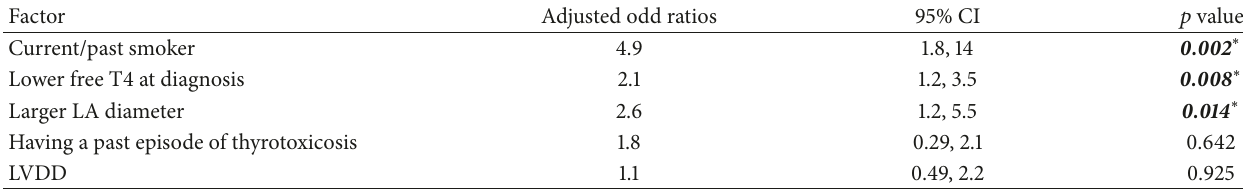
Table 3: Multivariate analysis to determine factors associated with persistent atrial fibrillation.